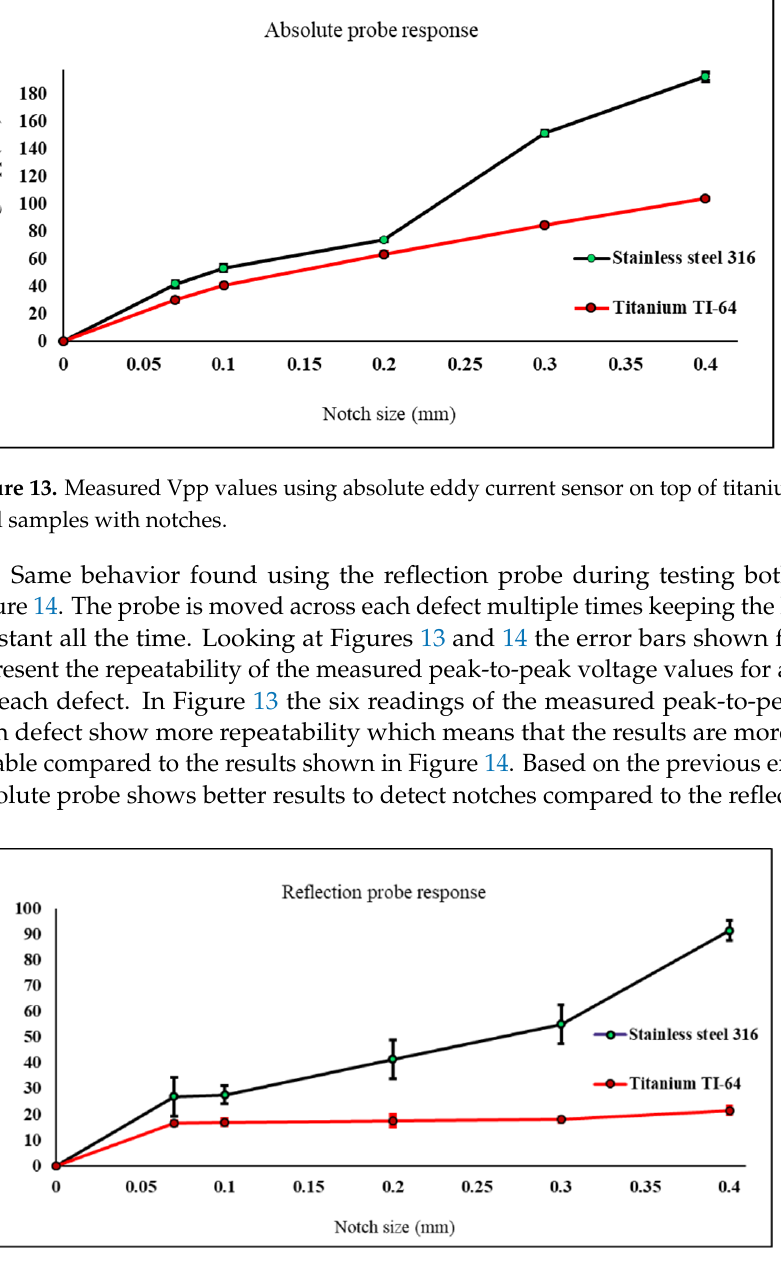
Figure 14. Measured Vpp values using reflection eddy current sensor on top of titanium and stainless-steel samples with notches.